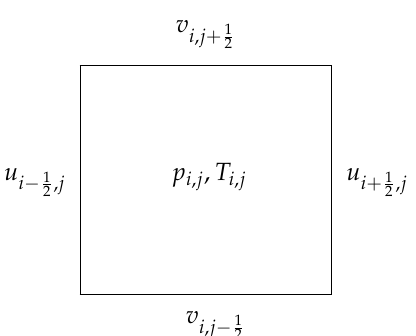
Figure 2. Description of numerical spatial cell: the velocity components are computed in the middle of the cell borders whereas the pressure and the temperature are computed at the center of the cell. (Reproduced with permission from [24]).